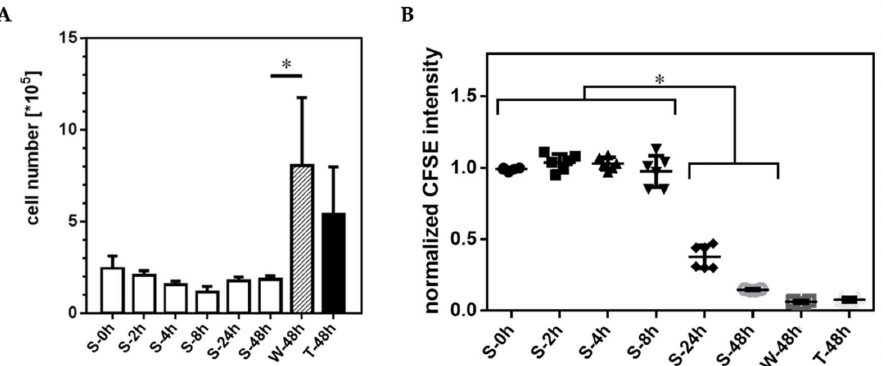
Figure 3. Proliferation of HUVEC under nonadherent conditions. ( A ) In contrast to controls cultured on TCP (W-48h, T-48h), total HUVEC numbers remained unchanged under nonadherent conditions on LAP, while the corresponding signal of the CellTrace-CSFE proliferation marker ( B ) progressively decreased during the cultivation period (Data shown as arithmetic mean ± standard deviation; * p < 0.05; n = 6 from two independent experimental series with n = 3 HUVEC seedings